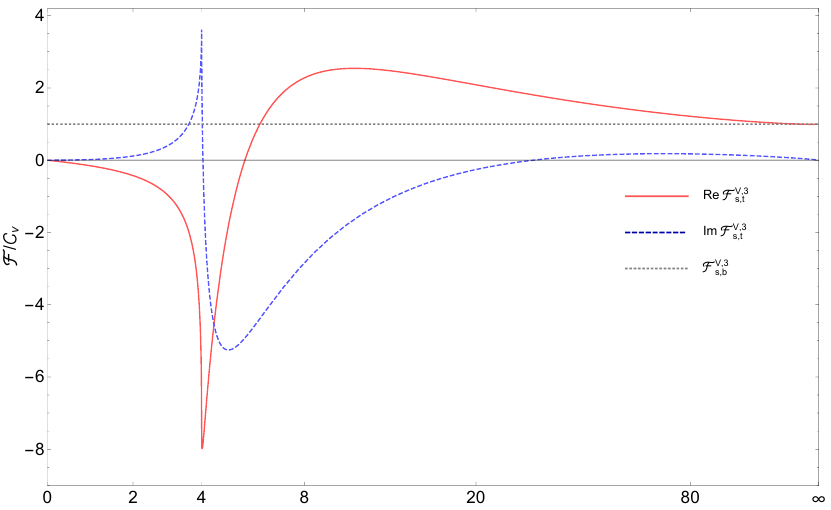
, normalized w.r.t. the t